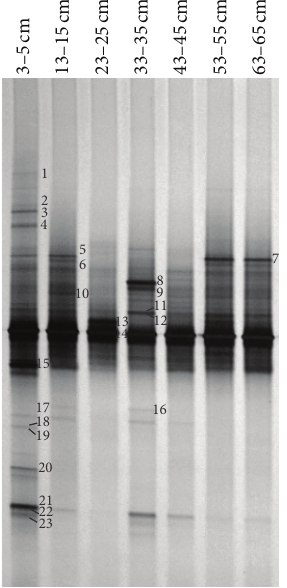
Figure 3: DGGE of PCR-amplified archaeal 16S rRNA gene frag- ments from total community DNA from different depths (indicated above the lanes) in the soil profile. Marked DGGE bands were excised and sequenced. The numbers of DGGE bands correspond to the ones on the phylogenetic tree in Figure